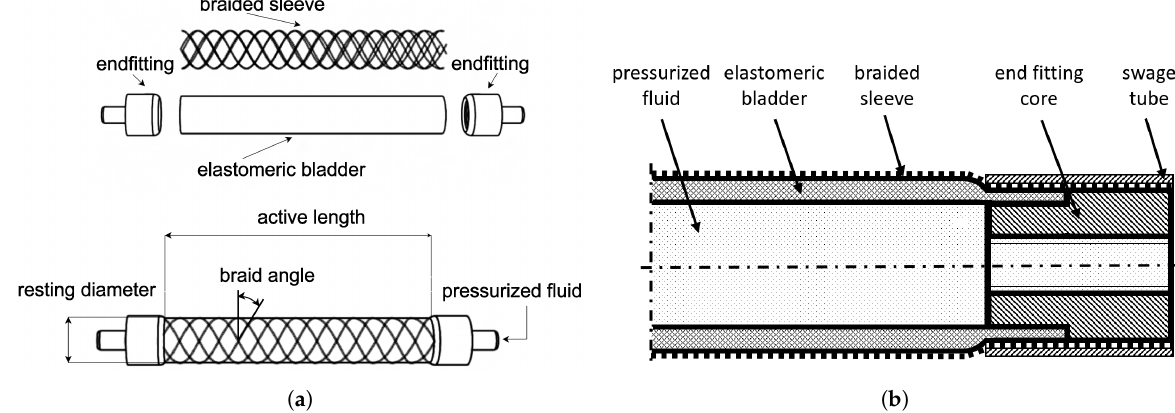
Figure 1. ( a ) Overview of a fluidic artificial muscle. Top: exploded view; bottom: assembly. A fluidic artificial muscle (FAM) is composed of three main components: braided sleeve, elastomeric bladder, and end fittings. End fittings fix the ends of the sleeve and bladder together, and seal the FAM on both ends. The braid angle of the sleeve is dependent on the FAM’s length and diameter. ( b ) Half cross-sectional view of a FAM with swaged end fittings. The elastomeric bladder is surrounded by a braided sleeve. The bladder and the sleeve are fixed to the end fitting by “compressing” the bladder and the sleeve between a swaged tube and the core of the end fitting. Pressurized fluid flows in and out through a threaded channel in the end fitting. The end fitting can be attached to a load with a hollow and threaded stud fastened to the